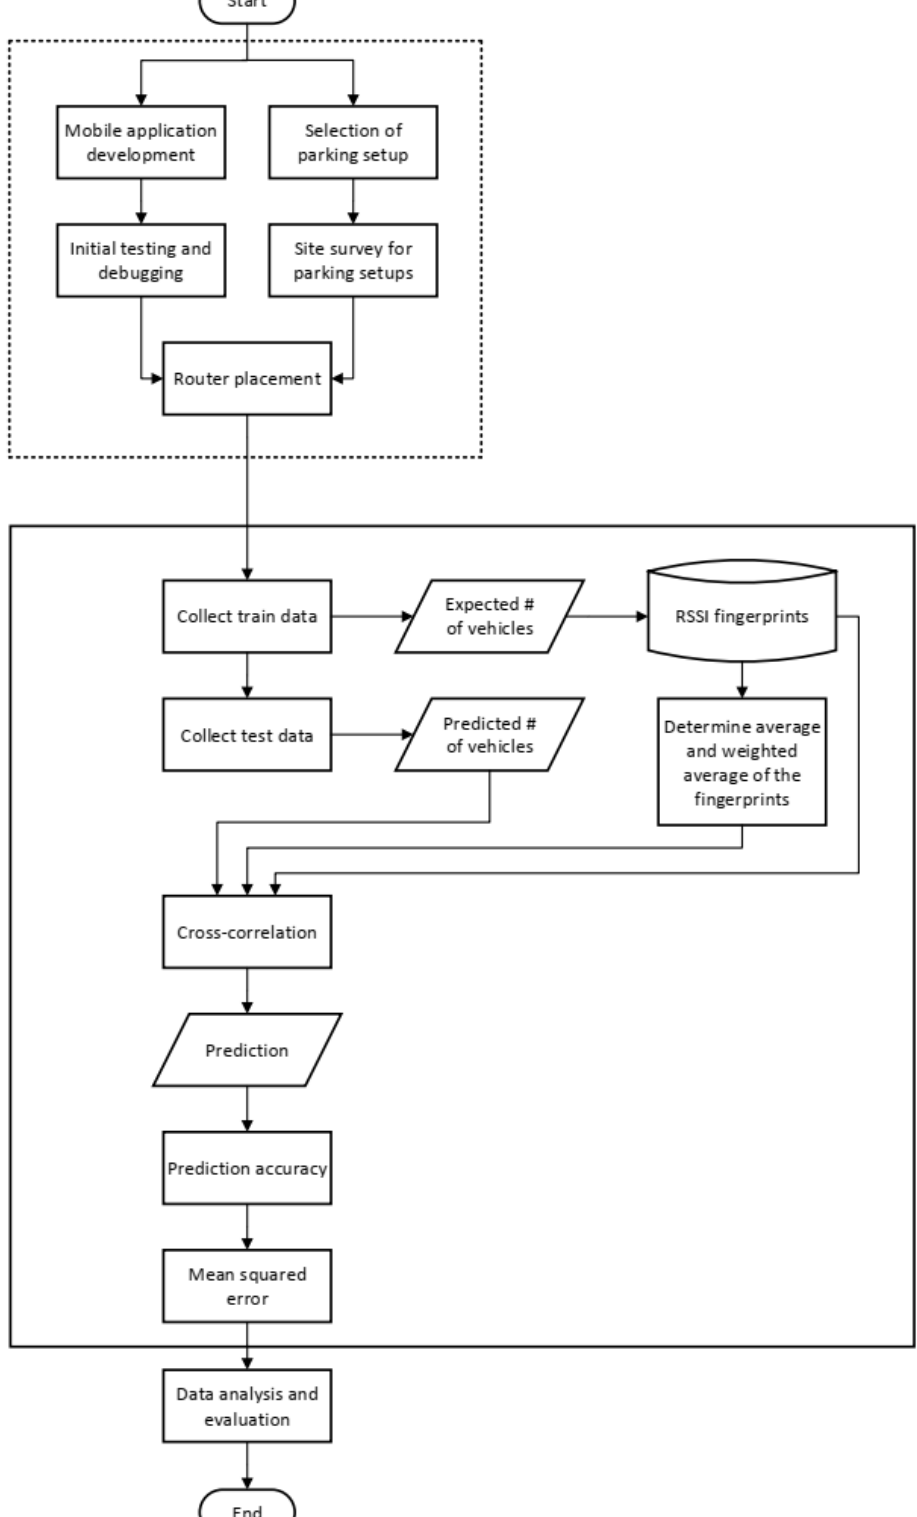
Figure 1. General flowchart of the research